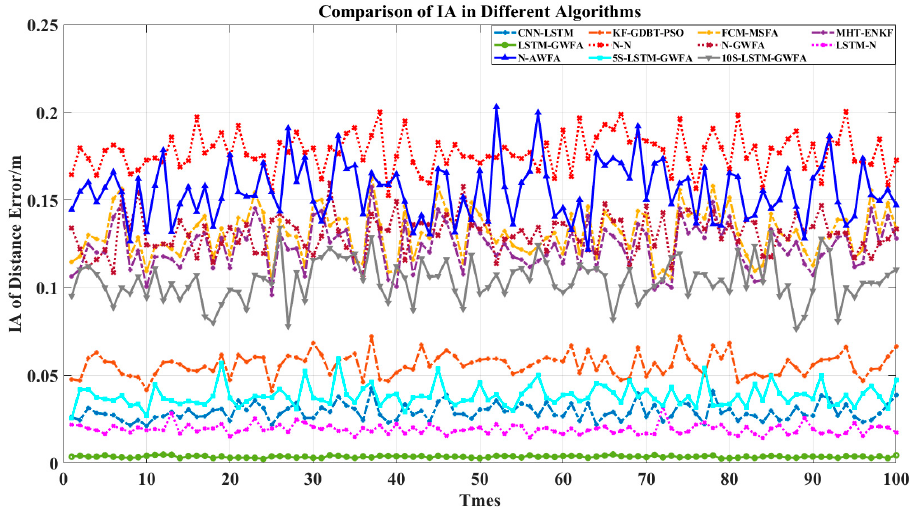
Figure 6. Comparison of IA with 100 tracks in different algorithms.